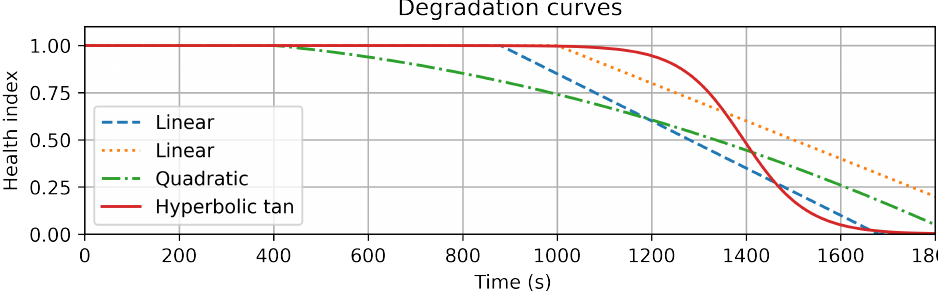
Figure 4. Possible degradation curves with different degradation onset times, degradation rates, changes in the degradation rate over time, and lifetime